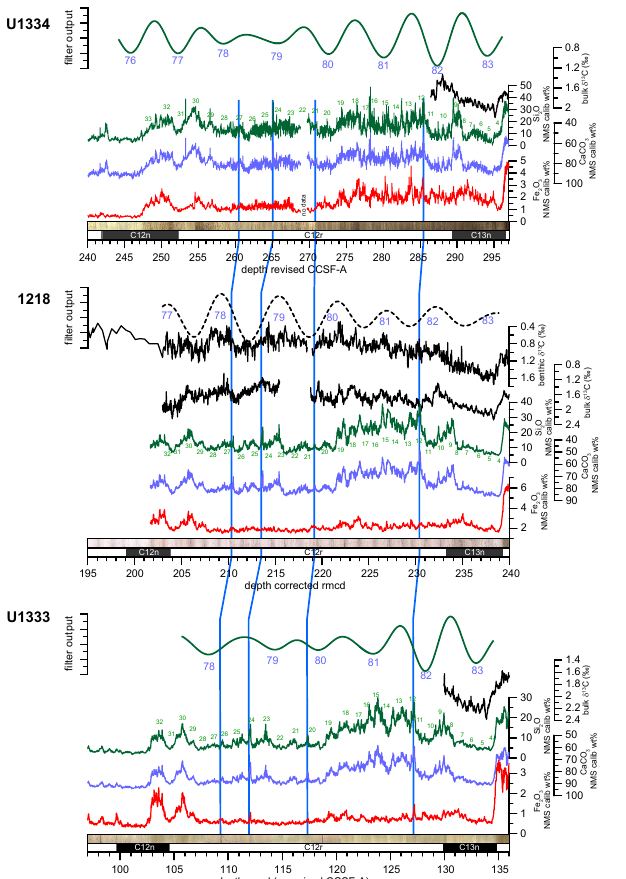
Figure 4. High-resolution XRF core scanning data, bulk and ben- thic stable carbon isotope data, core images, and cyclostratigra- phy from Chron C13n to C15r for Sites U1334, 1218, and U1333 in the depth domain. For details see caption of Fig. 2. 405kyr band pass filters: for Site U1334 from Si data (green line; 0 . 34 ± 0 . 102cm − 1 ; 2.95m band in Supplement Fig. S5a) and bulk sta- ble carbon isotopes (dashed black line; 0 . 33 ± 0 . 099cm − 1 ; 3.03m band in Supplement Fig. S1a); for Site 1218 from Si data (0 . 42 ± 0 . 126cm − 1 ; 2.38m band in Supplement Fig. S5b); for Site U1333 from Si data (green, 0 . 82 ± 0 . 25cm − 1 ; 1.22m band in Supplement Fig. S5c) and bulk stable carbon isotopes (dashed black line; 0 . 82 ± 0 . 25cm − 1 ; 1.22m band in Supplement Fig. S1b). Blue line marks the Eocene–Oligocene boundary (defined as 14% down in C13r–